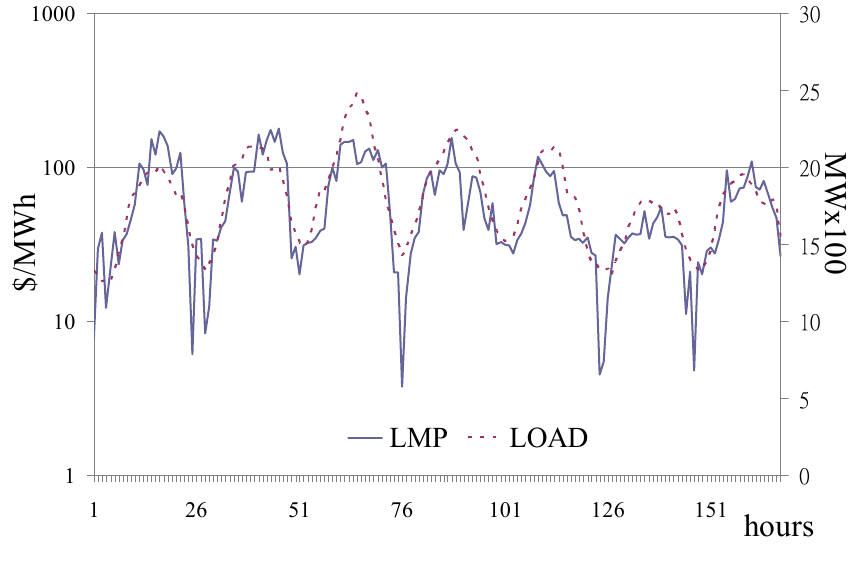
Figure 1. Daily LMPs in Fisk (4 kV) on 1–7 July